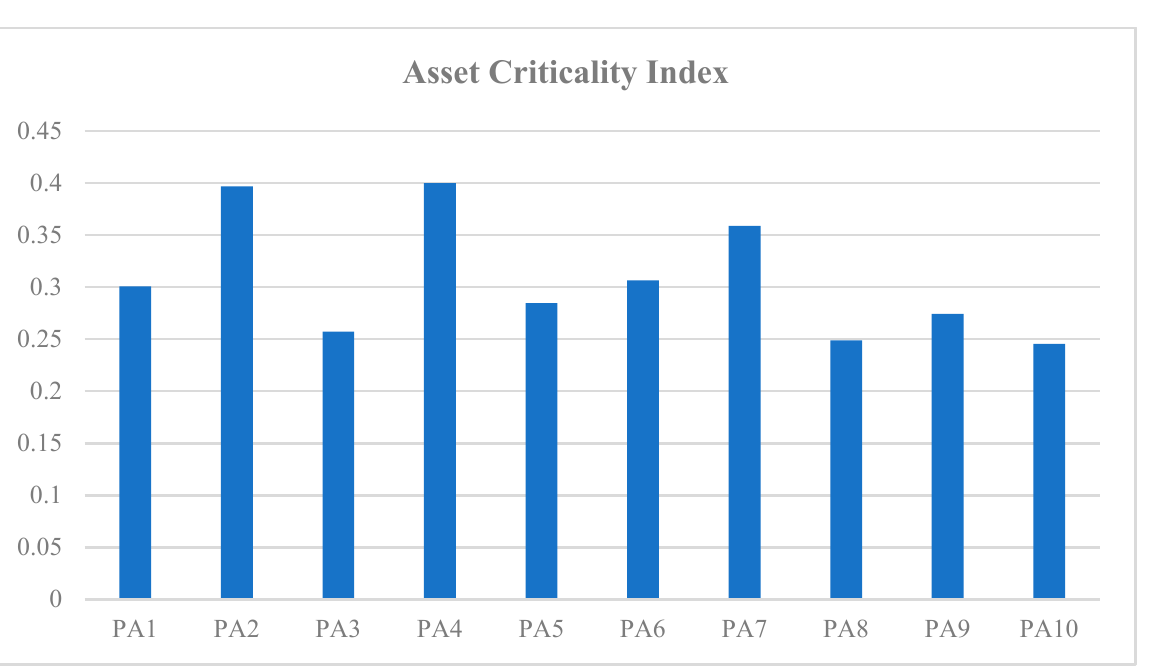
Figure 5. Results for economic, social, environmental, and resilient criticality of PA1 in GP.